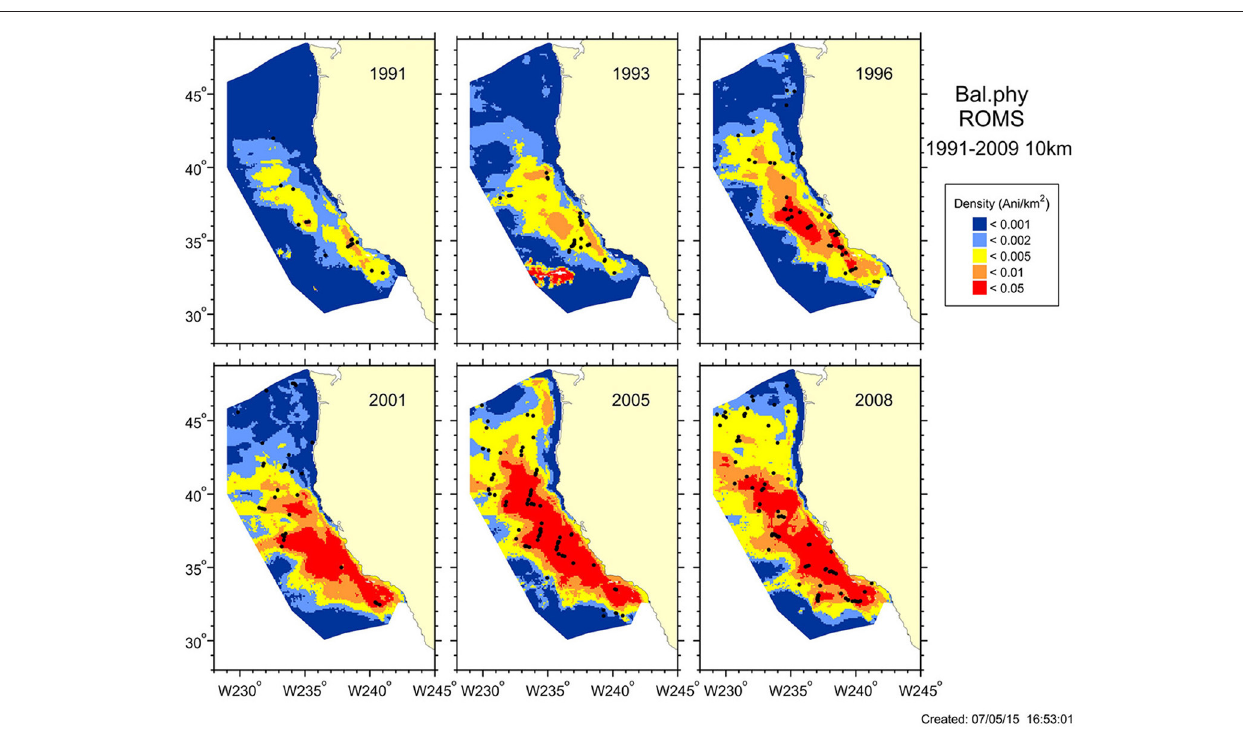
Frontiers in Marine Science |